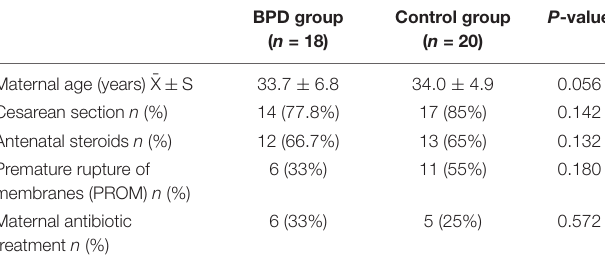
TABLE 2 | The basic maternal characteristics between BPD and control